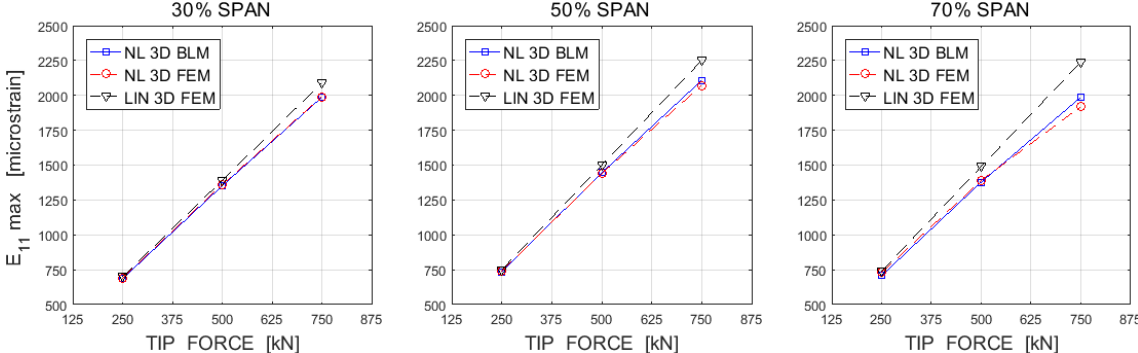
Figure 13. Max longitudinal strain E 11 in cross sections at 30%, 50% and 70% span for increasing F (bi-tapered